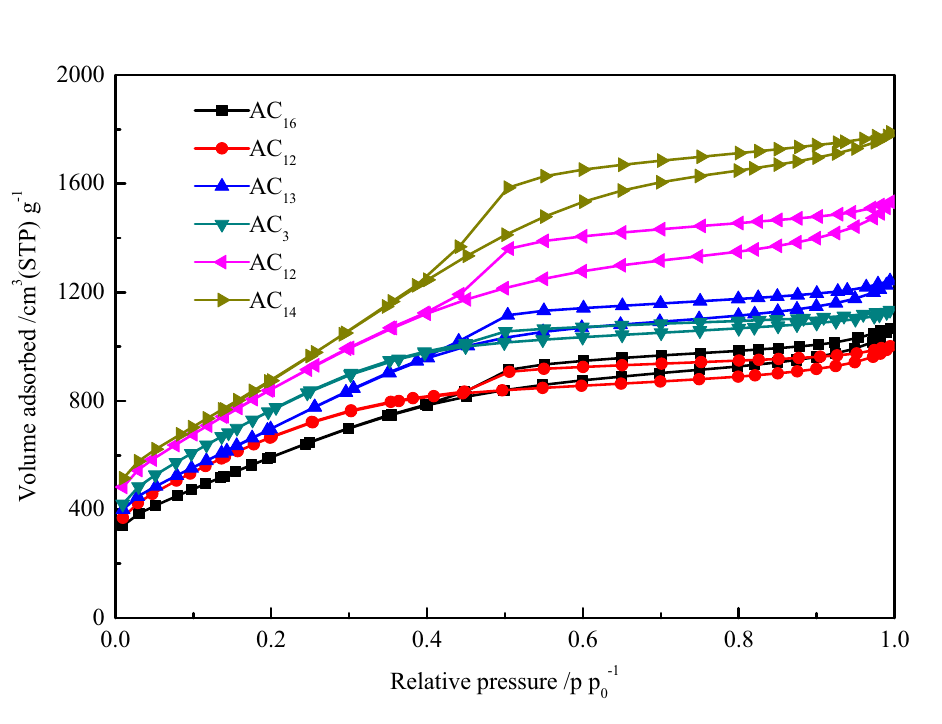
Figure 4. Nitrogen adsorption–desorption isotherms of